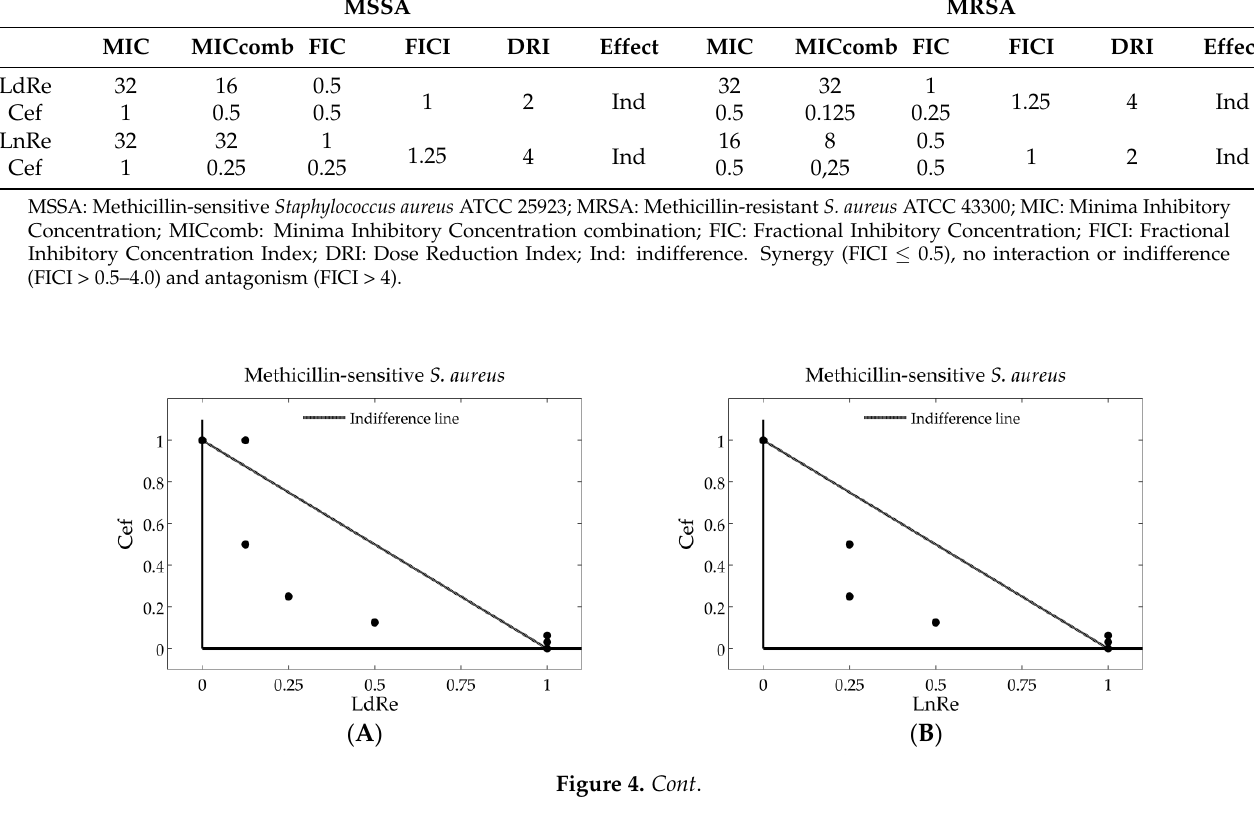
( D ) Figure 4. Normalized Isobolograms of LdRe or LnRe with cefotaxime against Methicillin-sensitive Staphylococcus aureus ATCC 25923 (MSSA) ( A , B ) and normalized Isobolograms of LdRe or LnRe with cefotaxime against Methicilin- resistant S. aureus ATCC 43300 (MRSA), respectively ( C , D ). The discontinuous line represents the indifference line and the points the experimental combinations at different levels.